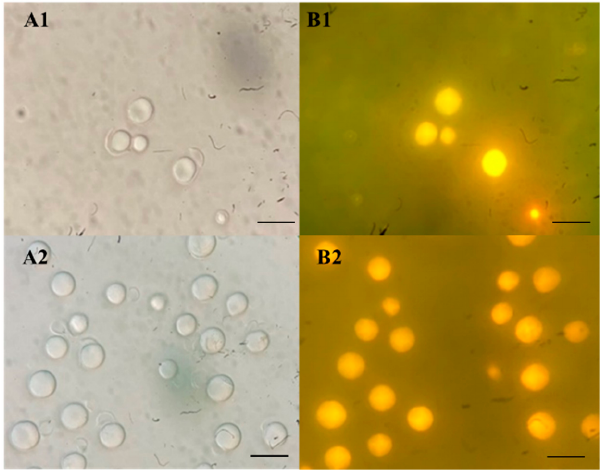
Figure 4. Photomicrographs of cell under light microscope ( A1 , A2 ) and lipid bodies by Nile red staining under fluorescence microscope ( B1 , B2 ) of Lipomyces tetrasporus SWU-NGP 2-5 ( A1 , B1 ) and Lipomyces mesembrius SWU-NGP 14-6 ( A2 , B2 ) grown in 2G2M broth for 7 days. The bar represents as 10 µm. L. mesembrius SWU-NGP 14-6 accumulated lipid content up to 57.1% of dry biomass, with a highest lipid concentration of 5.20 ± 0.03 g L − 1 and a highest biomass concentration of 9.13 ± 0.36 g L − 1 . Few articles on lipid production by L. mesembrius have been published,